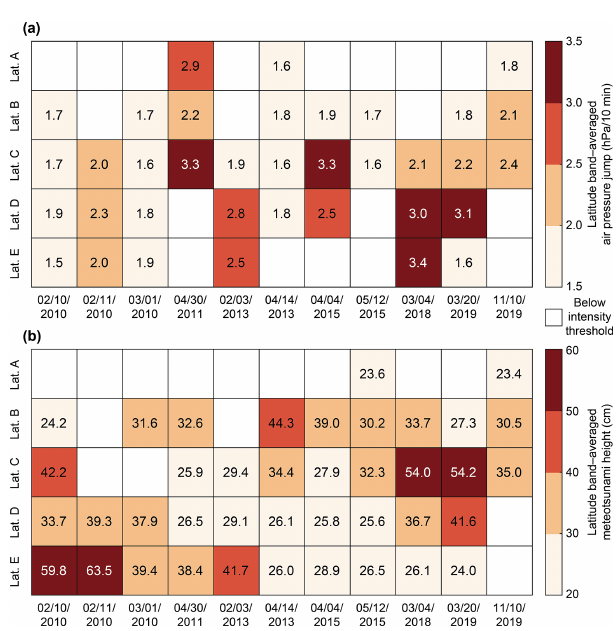
Figure 7. Latitude-band-averaged intensity of extreme meteot- sunami events: (a) air pressure jump and (b)